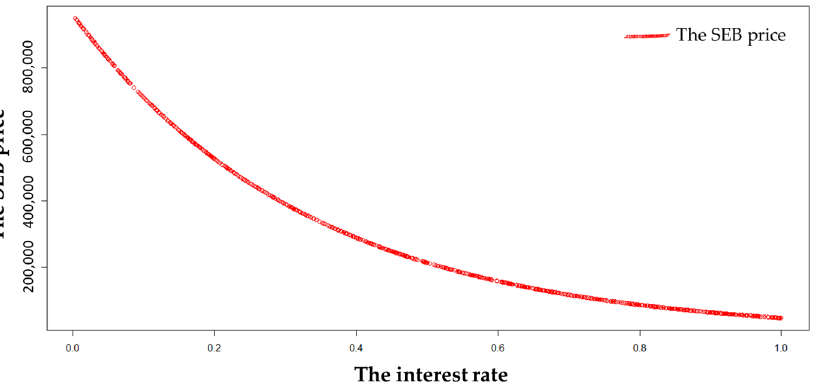
Figure 21. SEB price based on seismic information in Cluster Type II with FV = IDR 1,000,000, T = 3, A ( C t ) = IDR 9167.